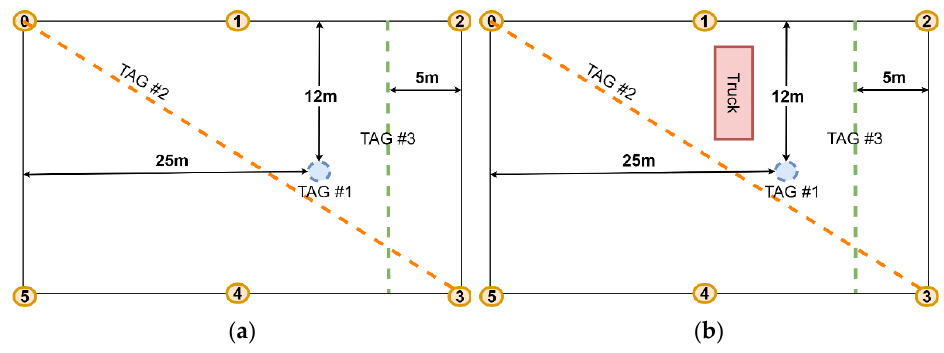
Figure 11. Worker tracking for scenarios ( a ) without blocking objects and ( b ) with blocking object. Dashed lines represent the trajectory of each worker carrying a tag and the dashed circle shows the static tag.